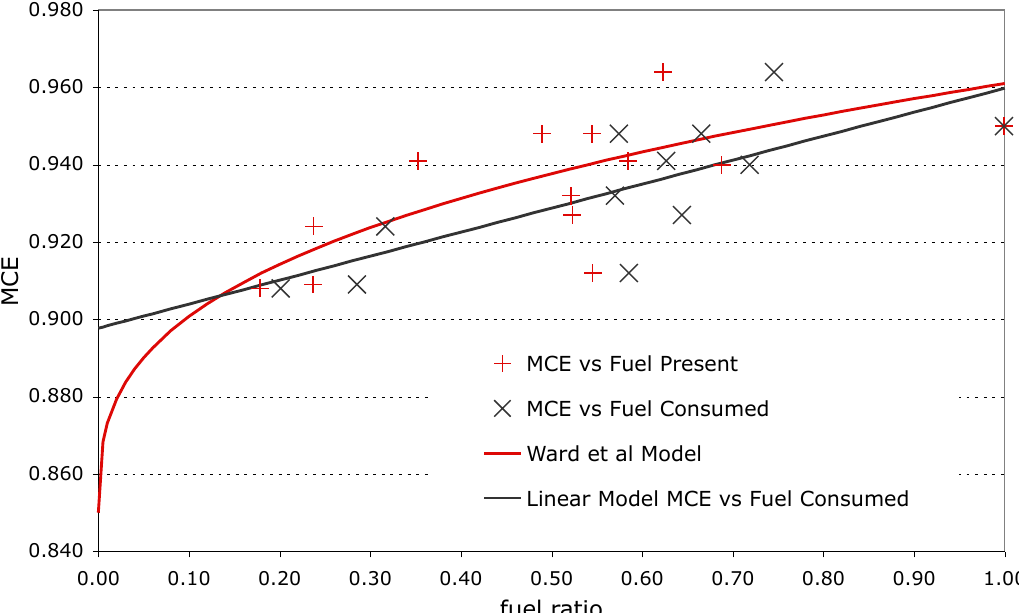
Fig. A1. Models of Modified Combustion Efficiency (MCE) against fuel ratio according to Ward et al. (1996) and derived as in the main text, as well as measured MCE by Ward et al. (1996) versus fuel ratio for either fuel present before the fire, or fuel consumed during the fire. The Ward et al model is a function of the fuel ratio of the fuel present, the linear MCE model derived here a function of the fuel ratio of the fuel consumed. The fuel ratio is defined as the amount of grass fuel (live grass and grass litter) divided by total fuel amount (including non-grass debris).